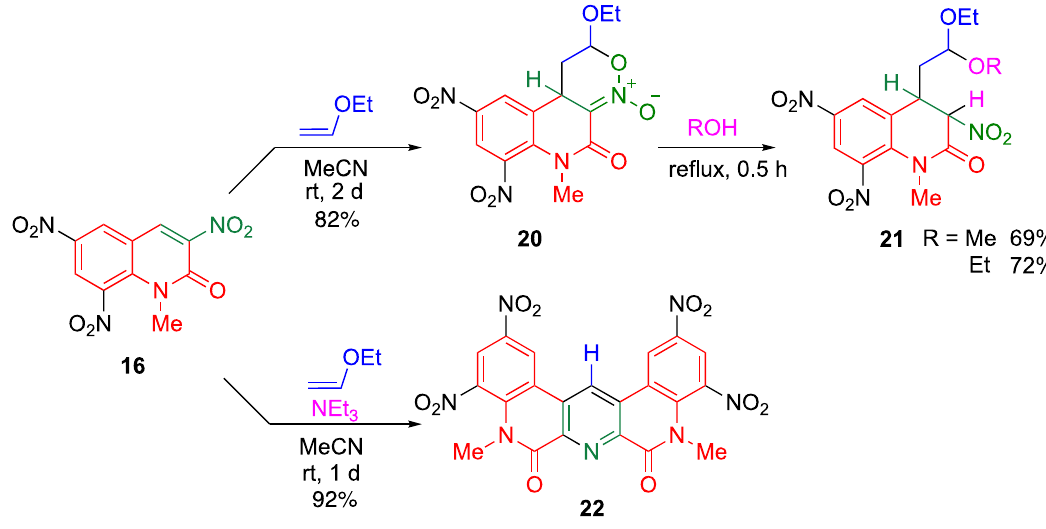
Scheme 5. Cycloaddition of 16 with